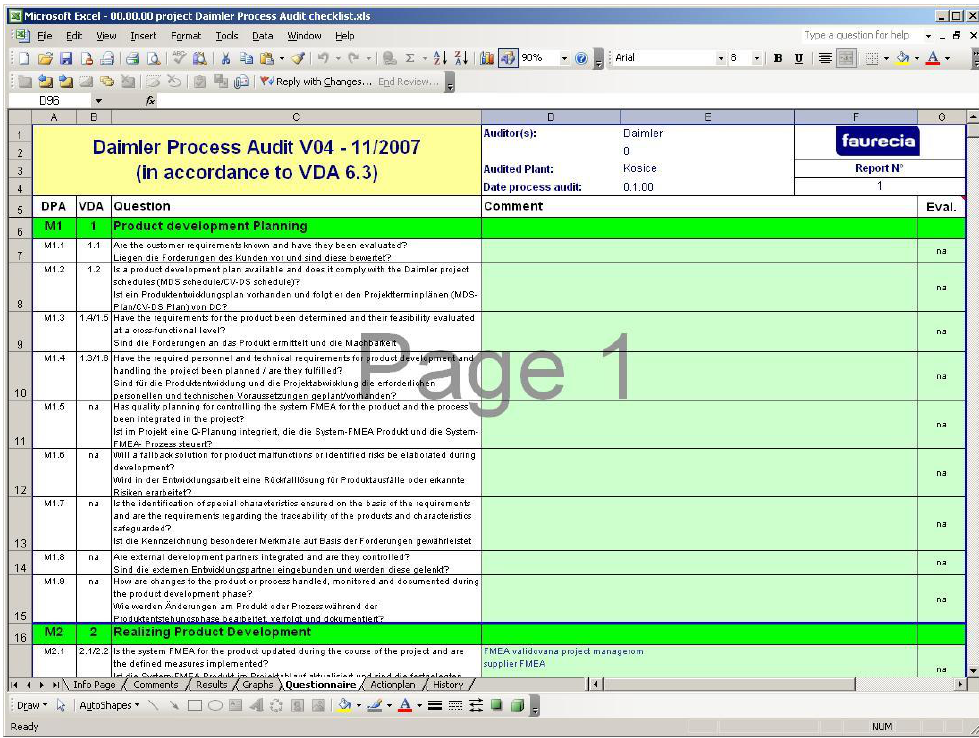
Figure 1 - Process audit questionnaire (Schmidt,